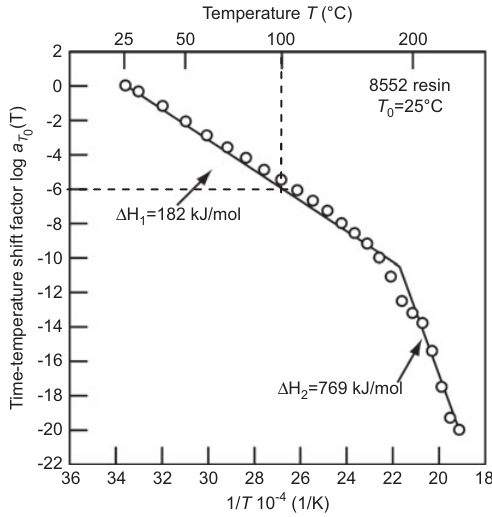
Figure 12 Master curve for storage modulus of Hexcel 8552 resin system (data generated by Miyano).